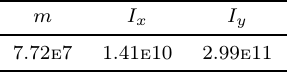
Table 9: Rigid body inertia